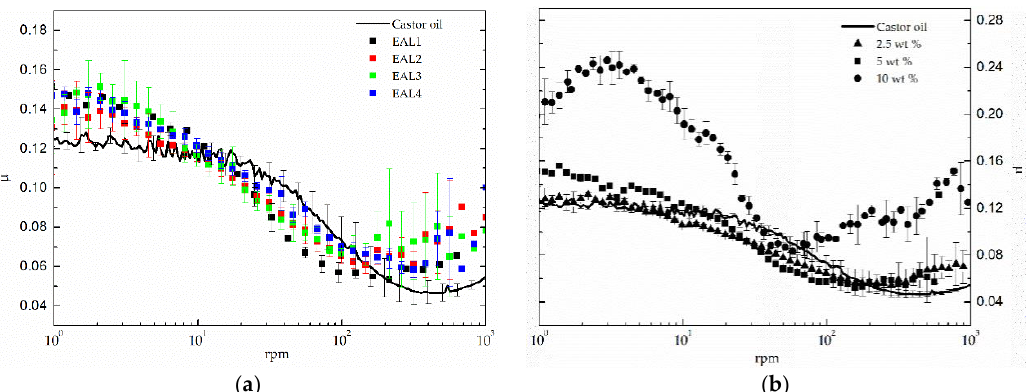
Figure 9. Friction coefficient versus rotational speed curves for epoxidized lignin-based oleogels as a function of ( a ) lignin epoxy index (5 wt % EAL) and ( b ) lignin concentration (EAL1 sample).